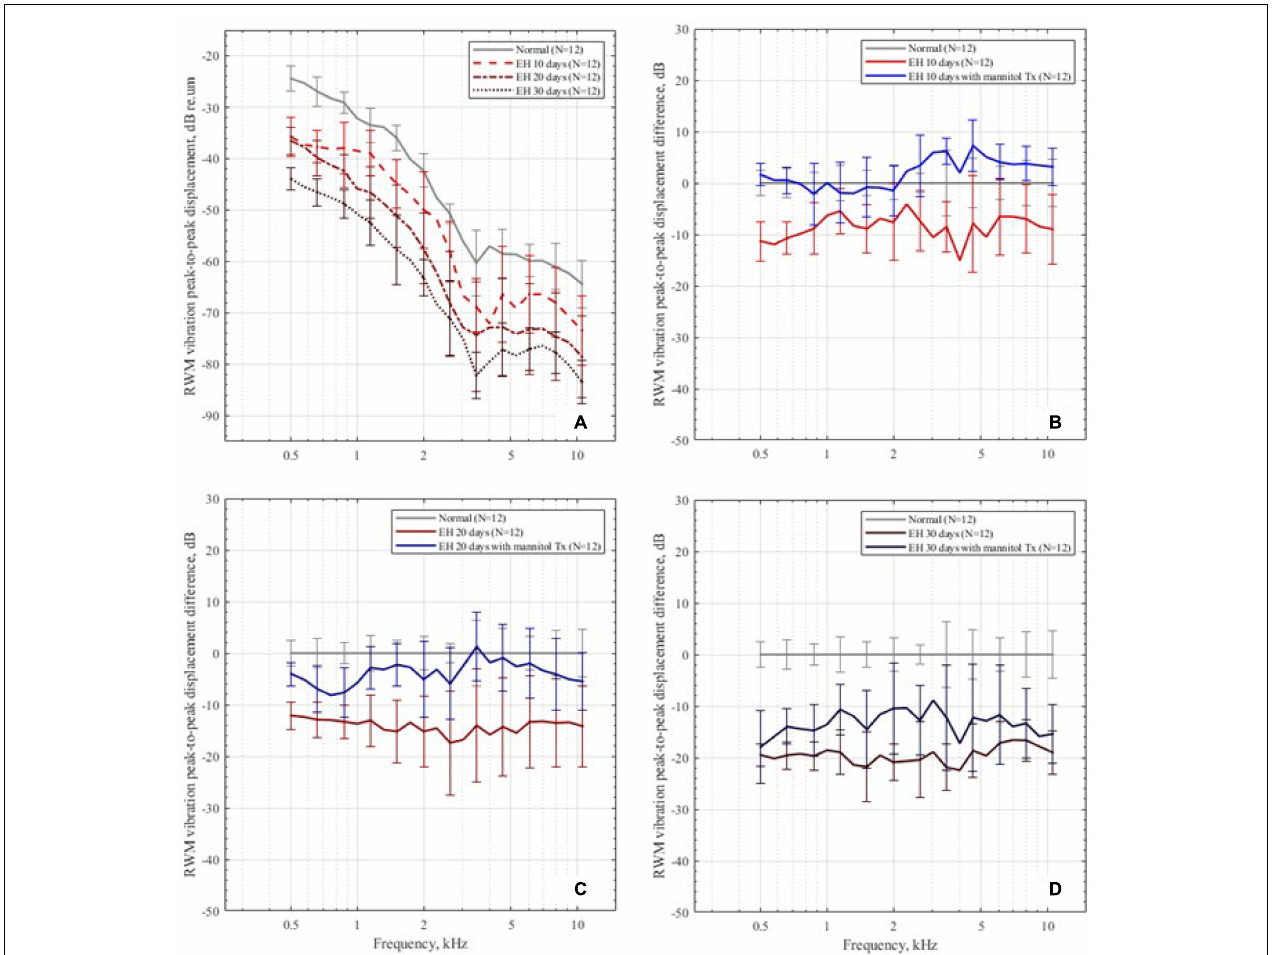
FIGURE 5 | The RWM peak-to-peak displacements in the dB scale. (A) The RWM peak-to-peak displacement in the control group and the EH 10-, 20-, and 30-day groups, presenting with mean and SD. The displacements are normalized by sound pressure in the ear canal. (B–D) The RWM peak-to-peak displacement differences in the 10-, 20-, and 30-day EH groups before and after dehydration treatment, compared with the normal